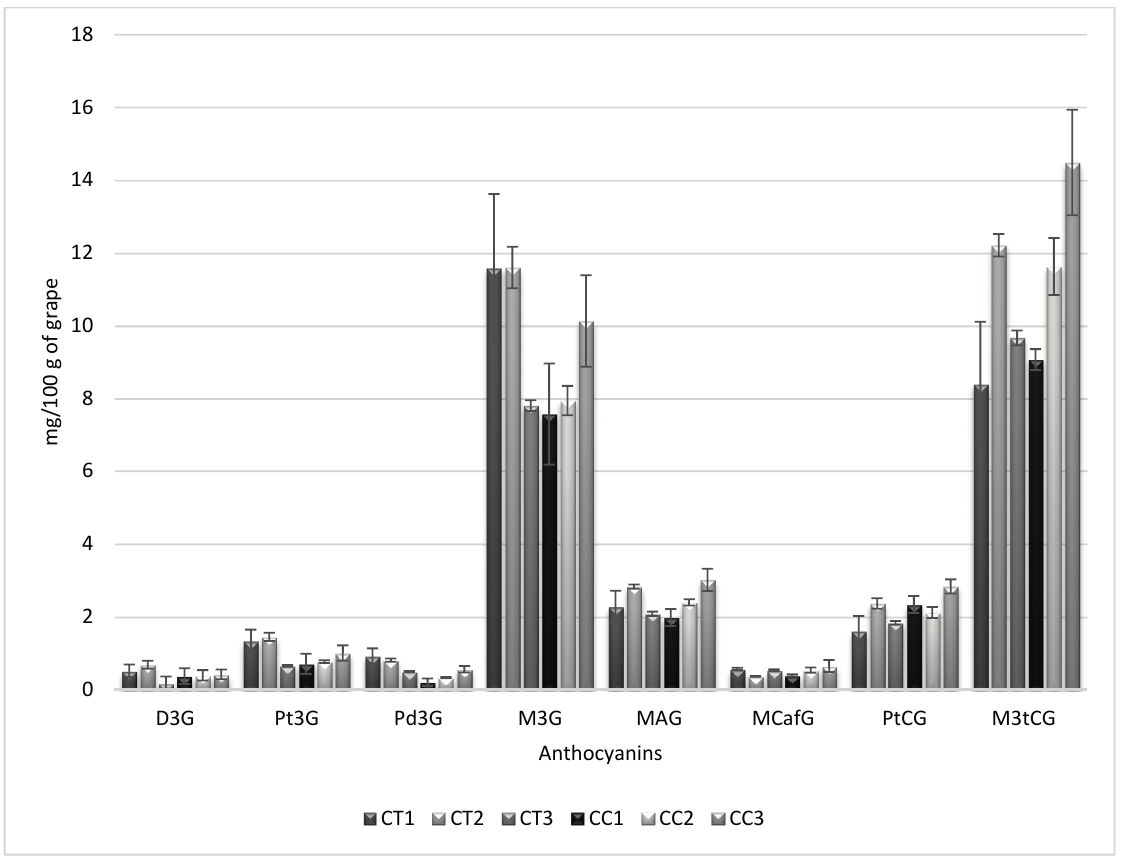
Figure 4. Evolution of the anthocyanin levels during phenolic maturation using the same grape variety (Tempranillo) but from different cultivar practices: CT: cluster thinning, CC: cover crops, in three different vineyard